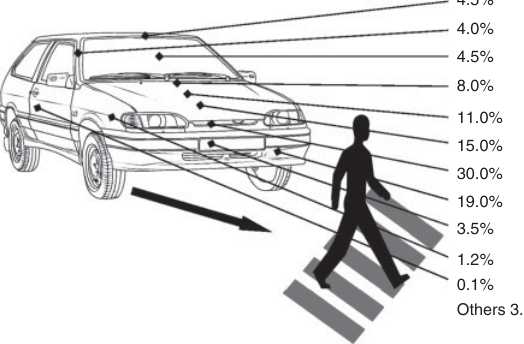
Fig. 2. The risk of pedestrian collision with various parts of a